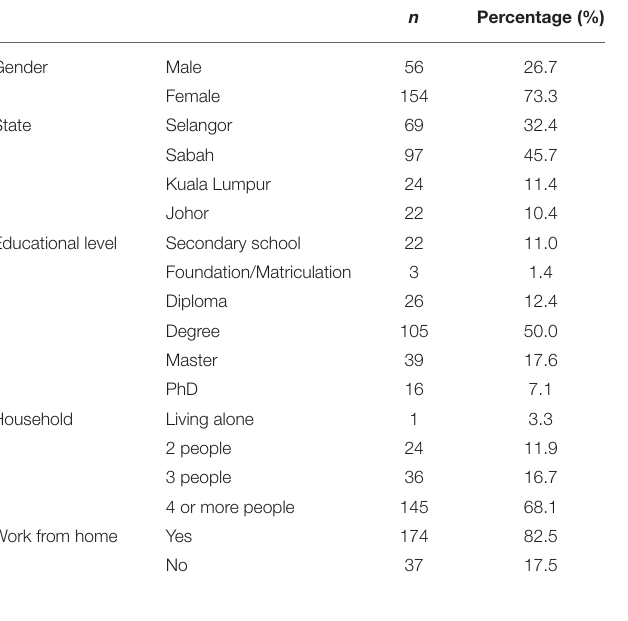
TABLE 1 | Sociodemographic characteristics of respondents ( n = 210).